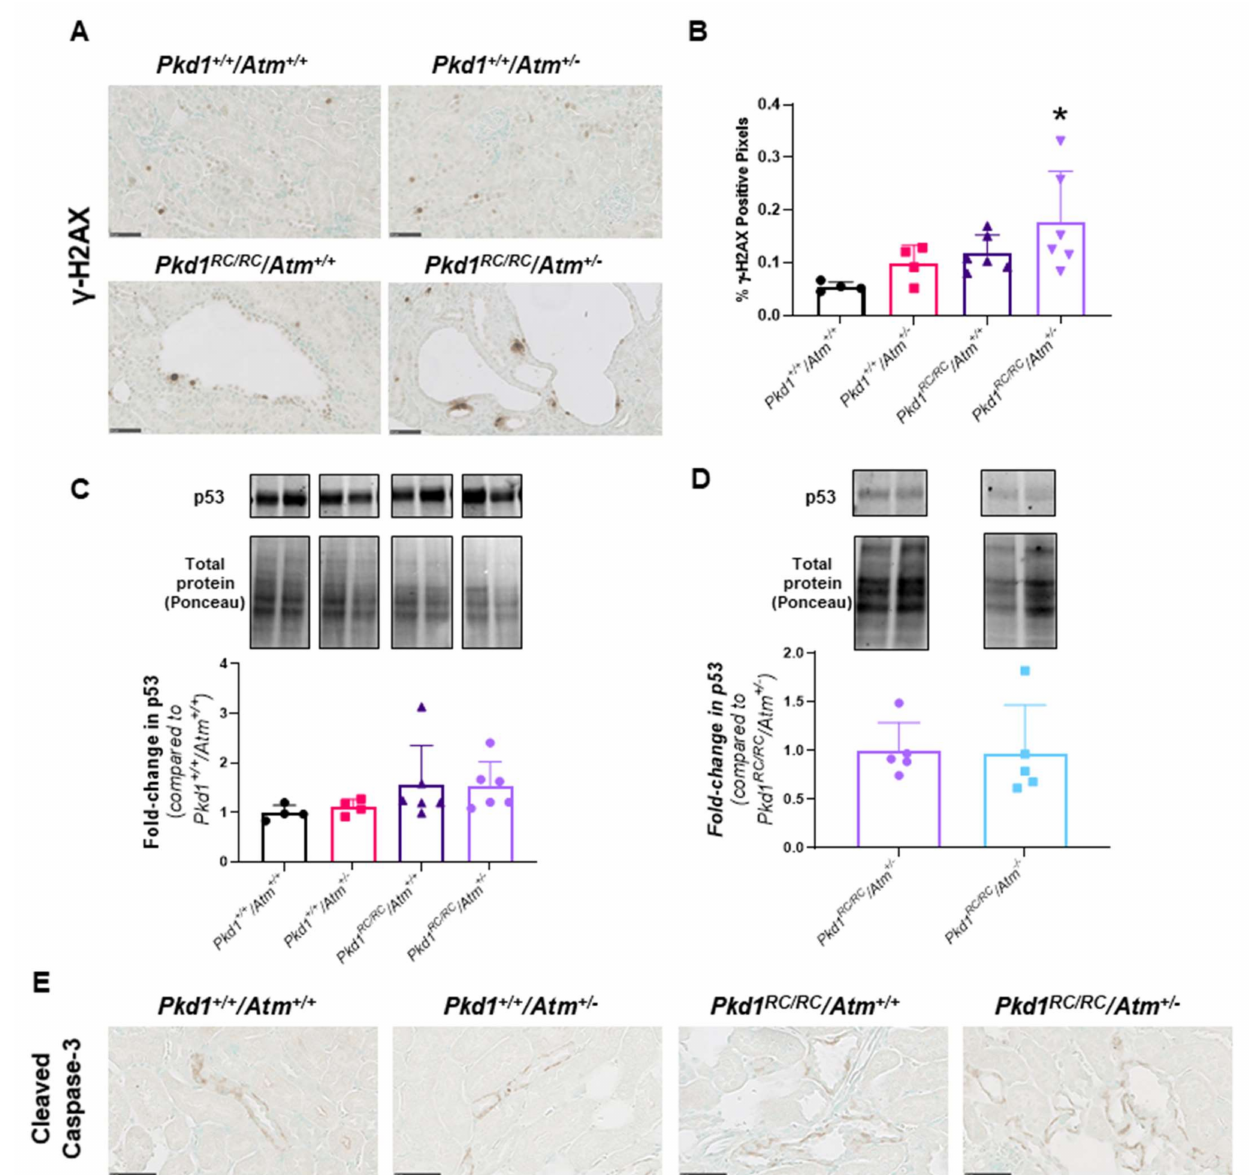
Figure 9. Effect of loss of ATM on DNA damage and p53 expression. ( A ) Representative histological images of γ -H2AX- positive staining in the renal cortex in the experimental groups. Scale bars, 50 µ M. ( B ) Mean γ -H2AX-positive staining score in the experimental groups. * p < 0.05 compared to Pkd1 +/+ /Atm +/+ . ( C ) Representative Western blot and quantification of renal p53 protein in the experimental groups. ( D ) Representative Western blots and quantification of p53 in Pkd1 RC/RC mouse kidneys with Atm +/ − or Atm − / − as fold-change compared to Pkd1 RC/RC /Atm +/ − . Data presented as mean ± SD ( n = 4–6 per group). ( E ) Representative histological images of apoptosis marker, cleaved caspase-3, positive staining in male wild-type ( Pkd1 +/+ ) and Pkd1 RC/RC mouse kidneys with Atm +/+ or Atm +/ − at 3 months of age. Scale bars, 50 µ